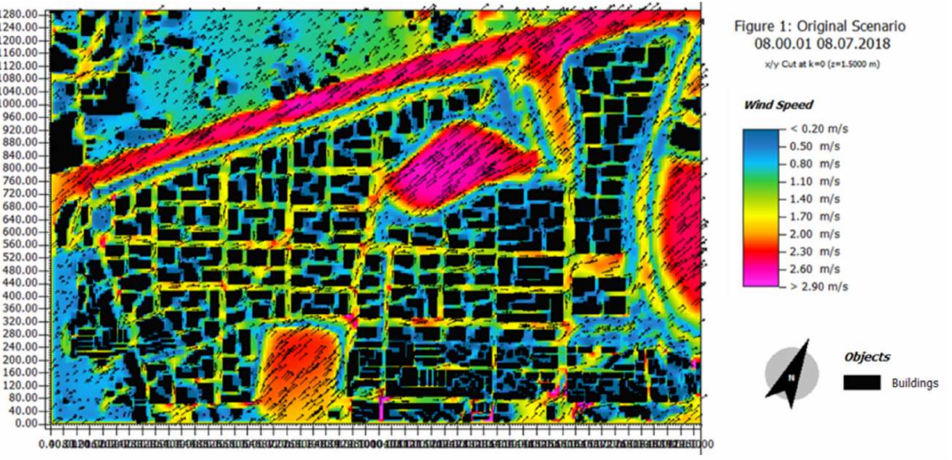
Figure 8. Simulated wind field in the initial scenario (height: 1.5